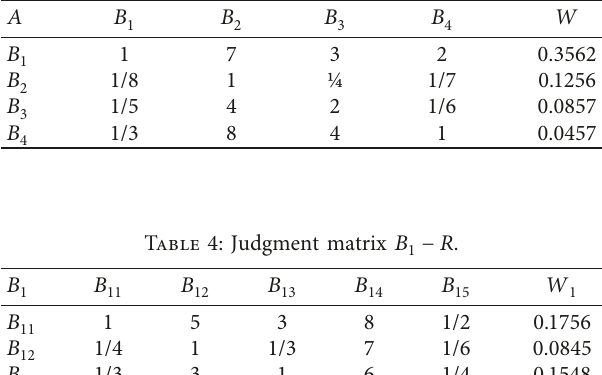
Table 3: Judgment matrix A − B